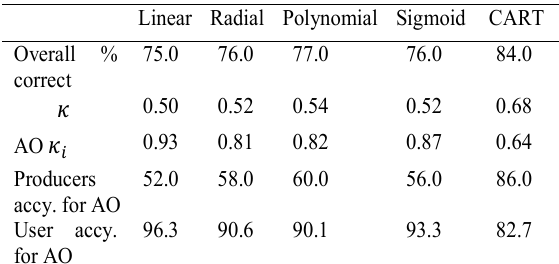
Table 4. Overall accuracy and kappa statistics for the binary autumn olive classification from CART and SVM.